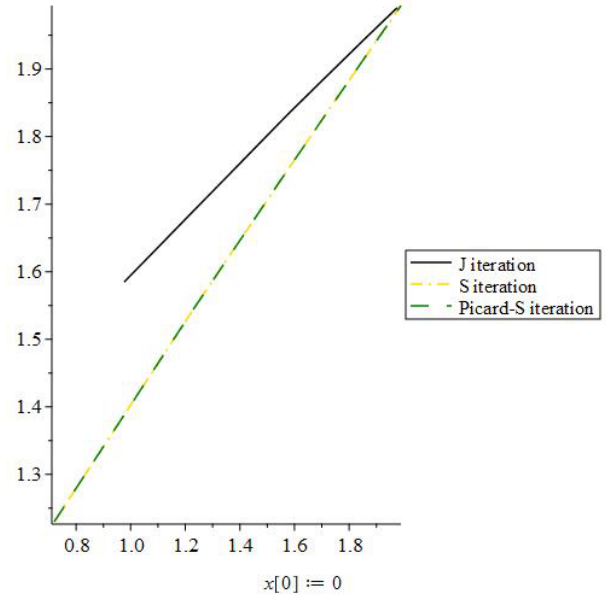
Figure 3. J iteration process convergence when the initial value is 0.